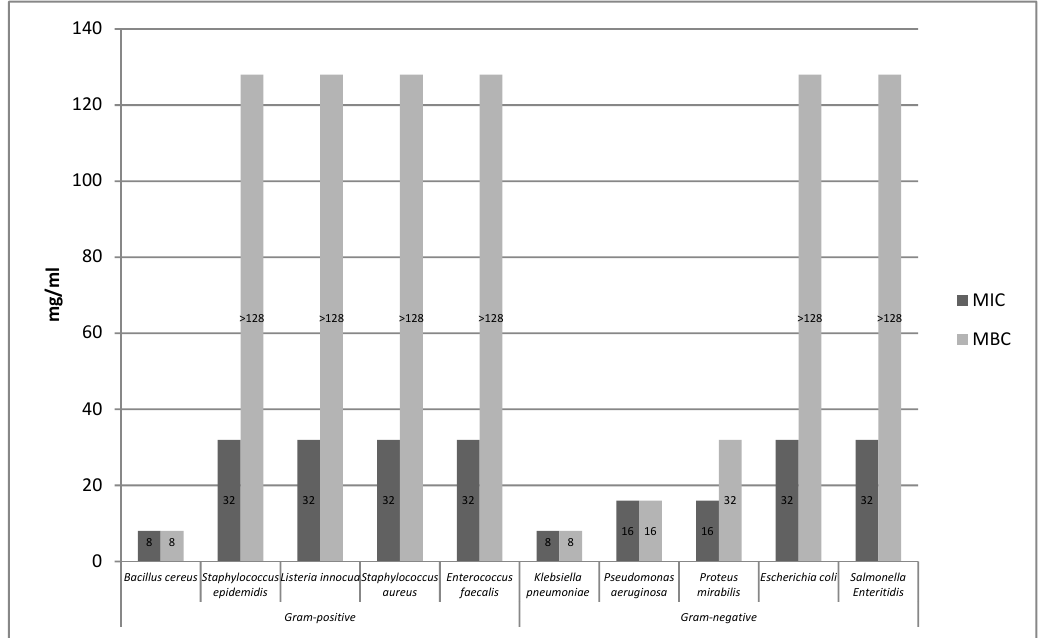
Figure 2. Minimum inhibitory concentration (MIC) and minimum bactericidal concentration (MBC) of ethanolic rose fruits extract (E) relative to Gram-positive and Gram-negative bacterial test strains.